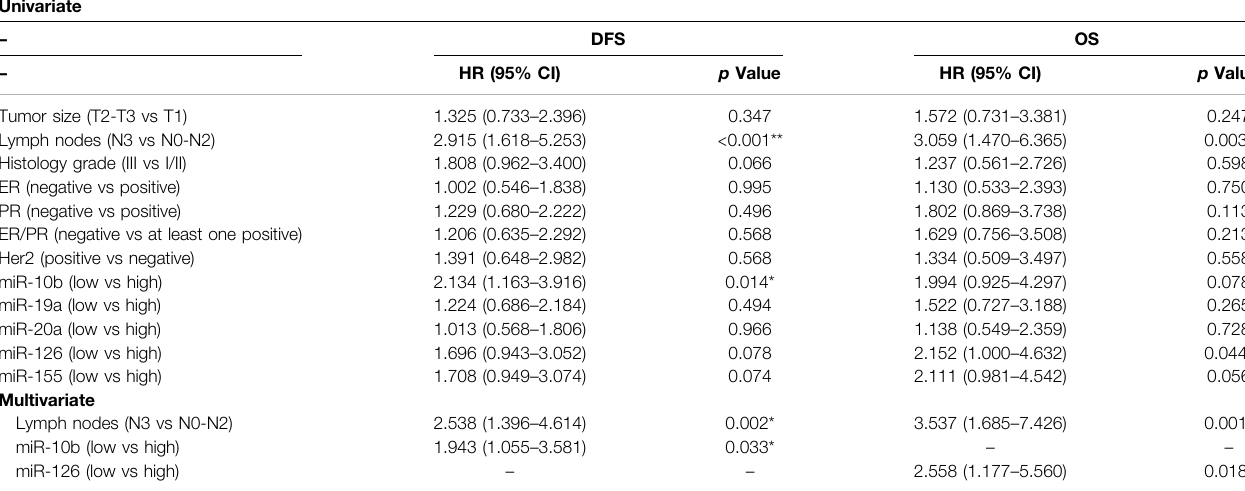
TABLE 2 | Univariate and multivariate analysis for DFS and OS in patients with early breast cancer ( n (cid:1) 140). Univariate